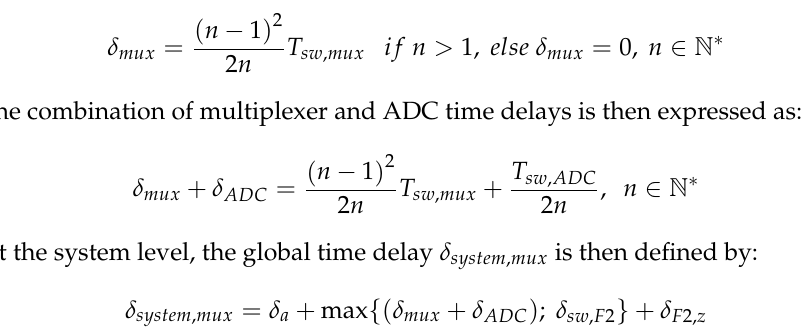
Figure 12. Spectra of input current controlled by DPSSOCC with a frequency 𝑓 𝑠𝑤,𝐴𝐷𝐶 of ( a ) 2 MHz and ( b ) 500 kHz.